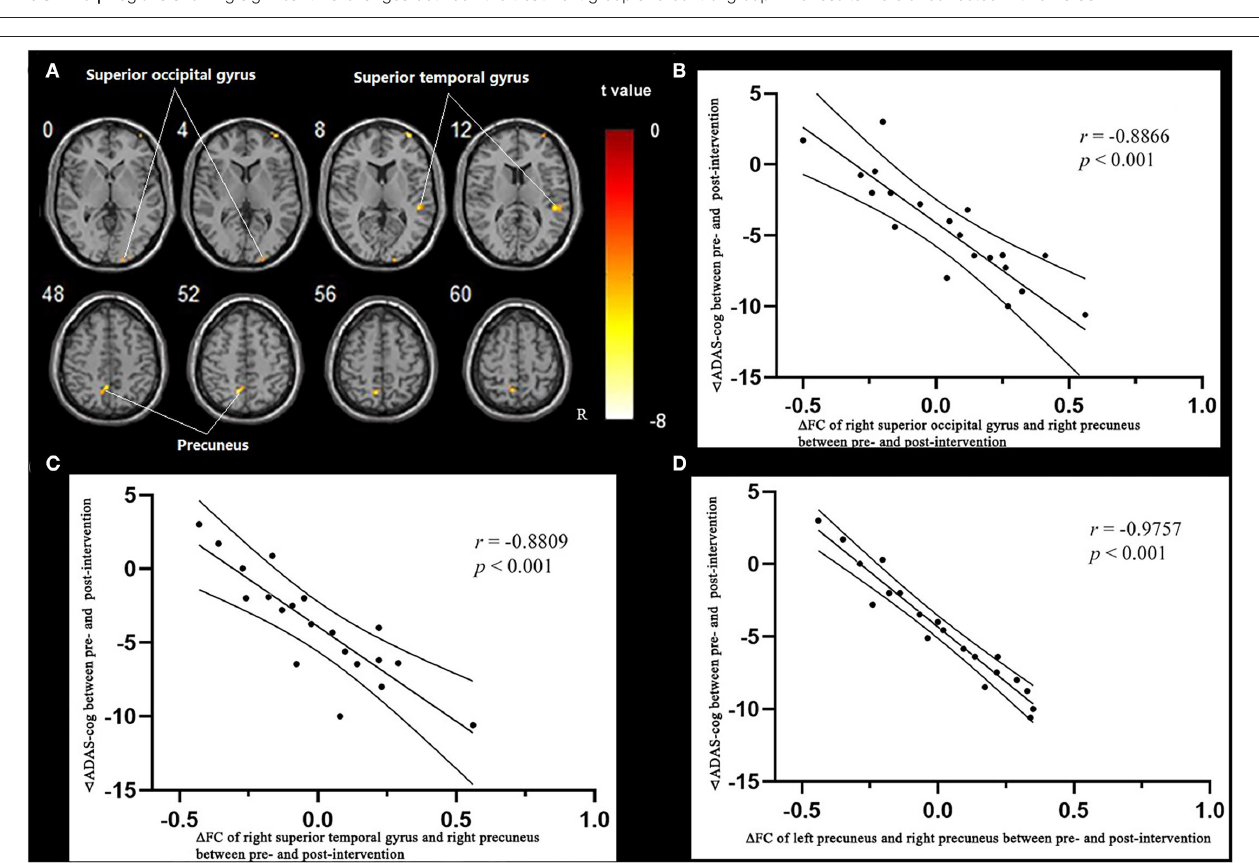
FIGURE 6 | Regions showing significant correlation in the change in FC in the treatment group to the change in ADAS-cog. (A) Multiple regression correlation results of significant correlation between FC changes and ADAS-cog value changes in the treatment group ( p < 0.001, FDR-corrected). (B) Pearson correlation results of the change in FC to the right superior occipital gyrus and the change in ADAS-cog value. (C) Pearson correlation results of the change in FC to the right superior temporal gyrus and the change in ADAS-cog value. (D) Pearson correlation results of the change in FC to the right superior temporal gyrus and the change in ADAS-cog value.